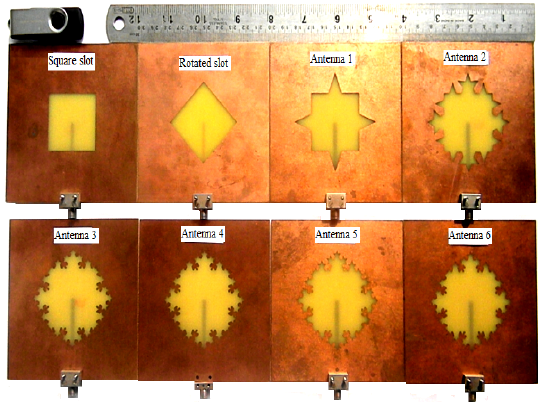
Figure 3. Prototype of fabricated slot